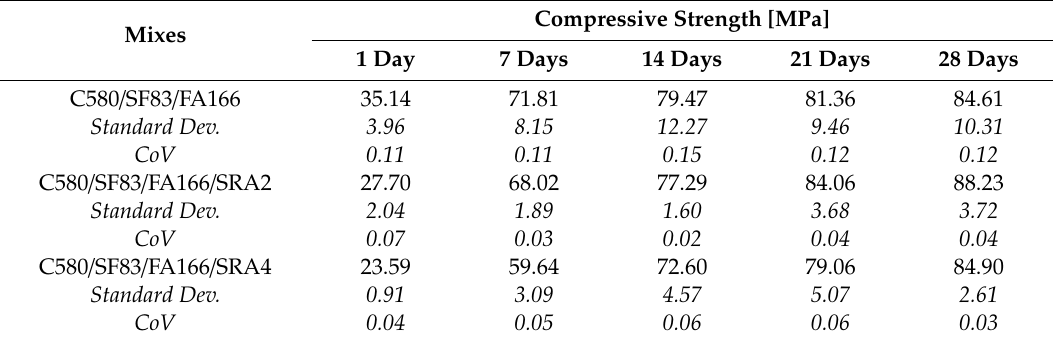
Table 2. Compressive strength.